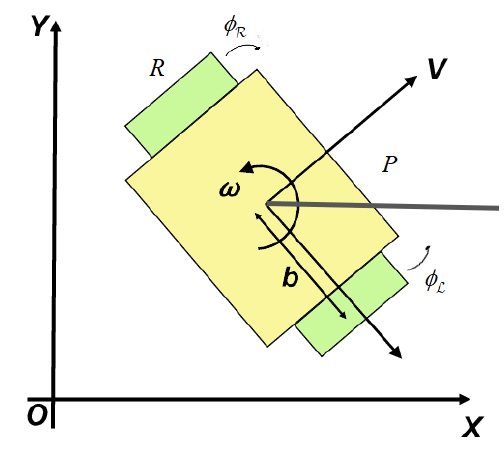
Figure 1. Diagram of wheeled mobile